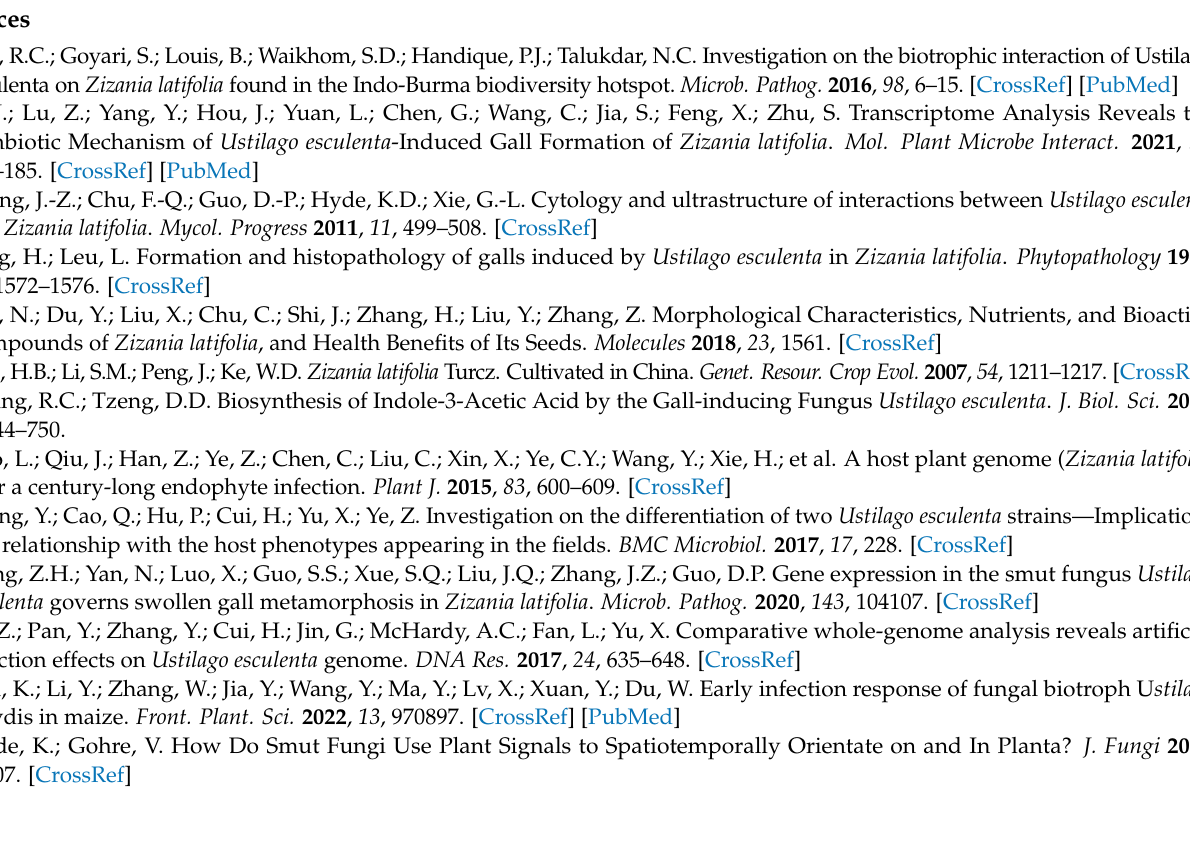
Table S4: Overall correlation of each replication at different stages; Table S5: Expressions of T- and MT-type U. esculenta at different stages; Figure S1: Mating and filamentous growth of the T- and MT-type U. esculenta ; Figure S2: The overall relevance of different modules; Figure S3: The infection of T-type U. esculenta did not induce callose deposition; Figure S4: Effects of g6161 deletion on haploid growth and mating; Figure S5: Gene expression pattern during the infection; Figure S6: Phylogenetic analysis of putative secretory proteins; Figure S7: Effects of g943, g4344, g1072, g4195, g4740, g5676 deletion on haploid growth, mating, and filamentous growth; Figure S8: Phenotypes of the swollen stems; Figure S9: The phenotypes of haploids on plant